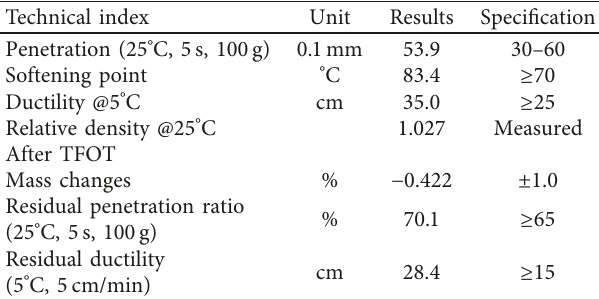
Table 2: Technical index of SBS I-D modified asphalt.